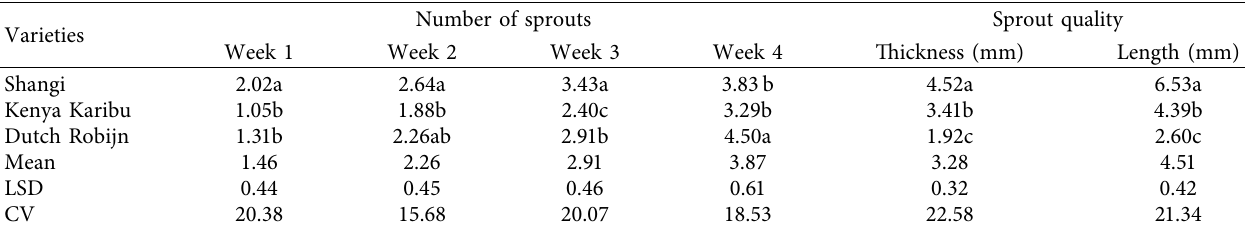
Table 4: Means for the number of sprouts and sprout quality of three potato varieties under a greenhouse in the 2019–2020 seasons. Varieties